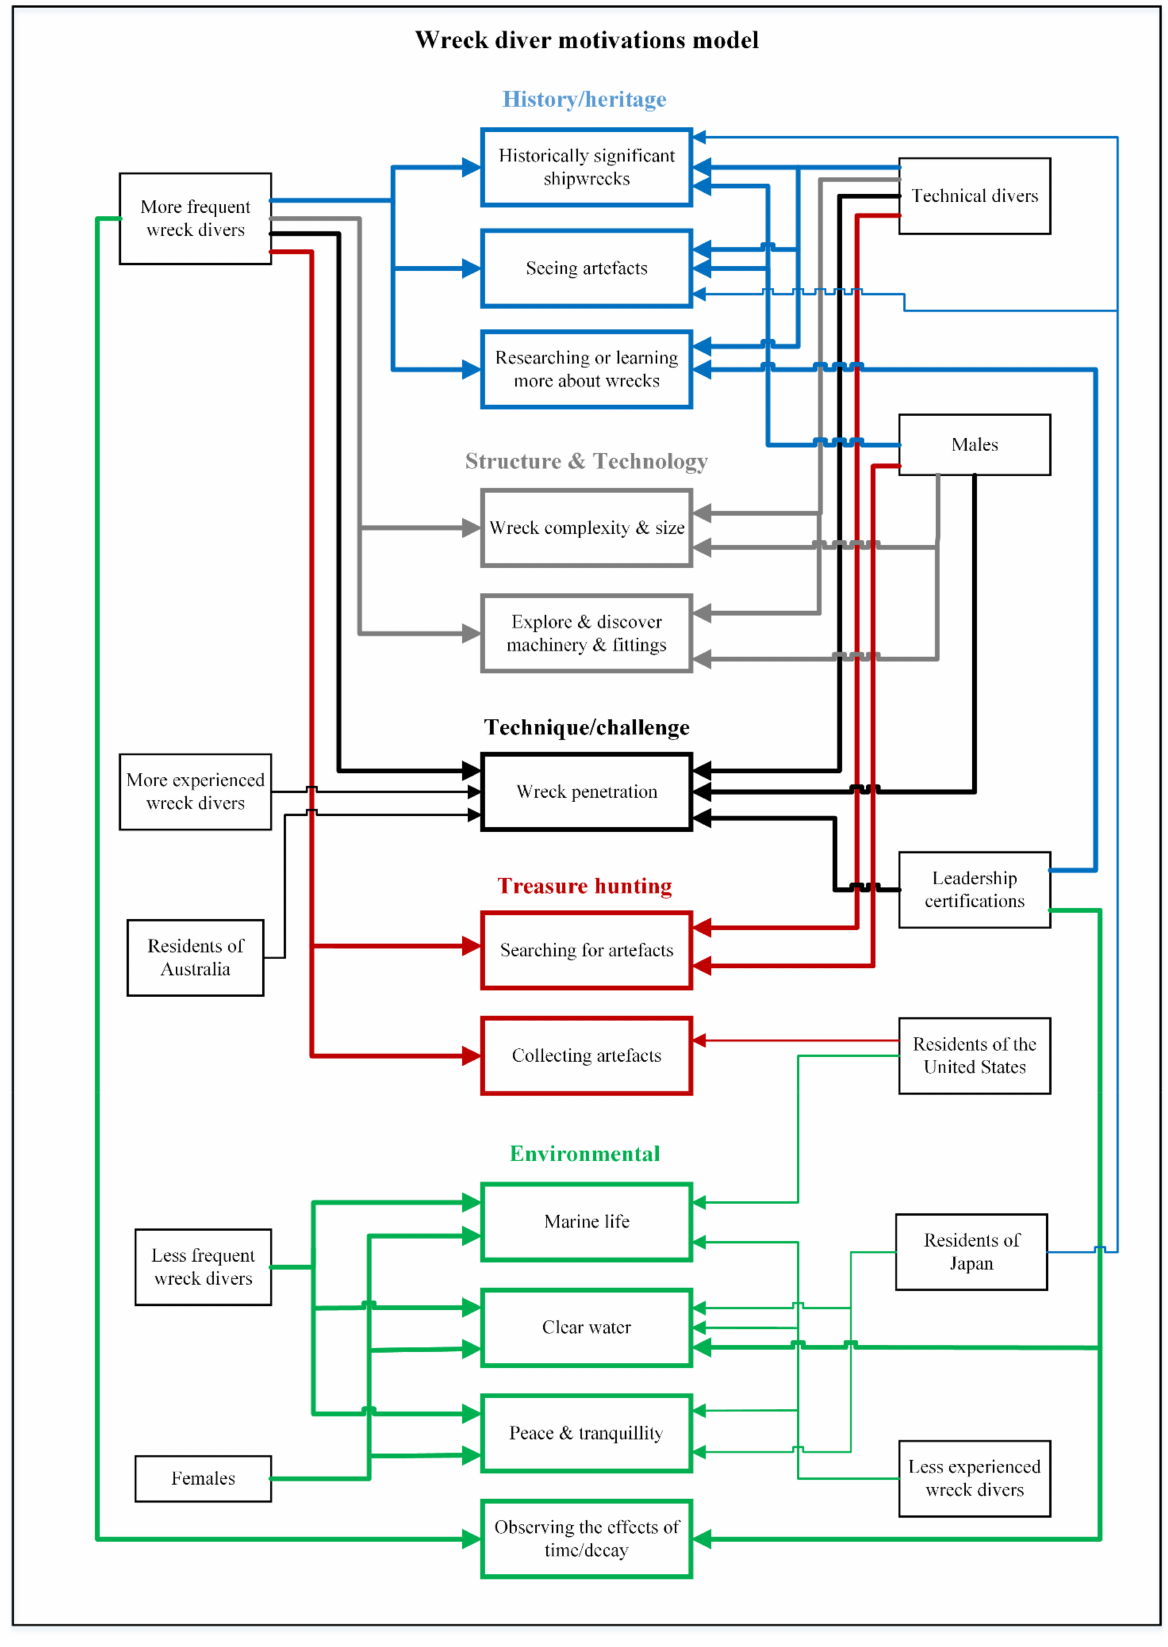
Figure 6. Wreck diver motivations model—adapted from [37] (p.